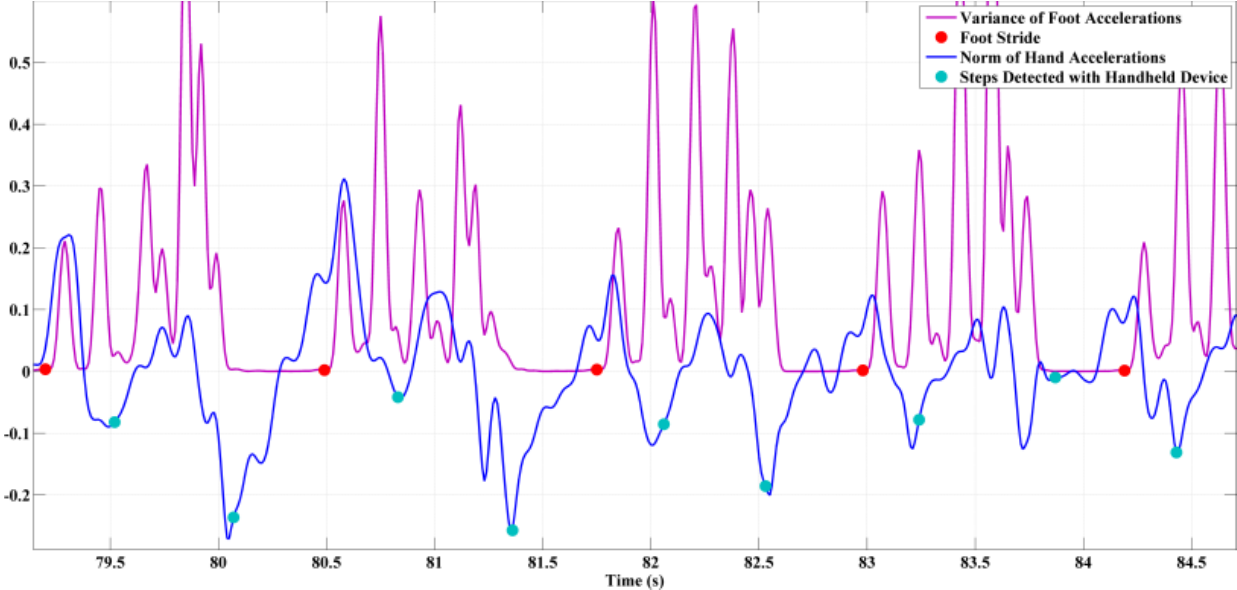
Figure 6. Comparison of the steps detected with the handheld inertial sensors (cyan dots) and the strides events detected with the sensors rigidly attached to the left foot (red